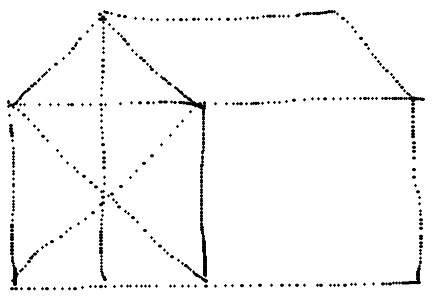
Figure 9. Strokes used for the construction shown in Figure 8. .